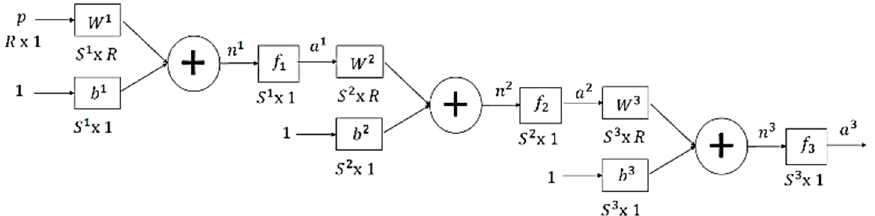
Figure 11. Structure of the Multilayer Neural Network.